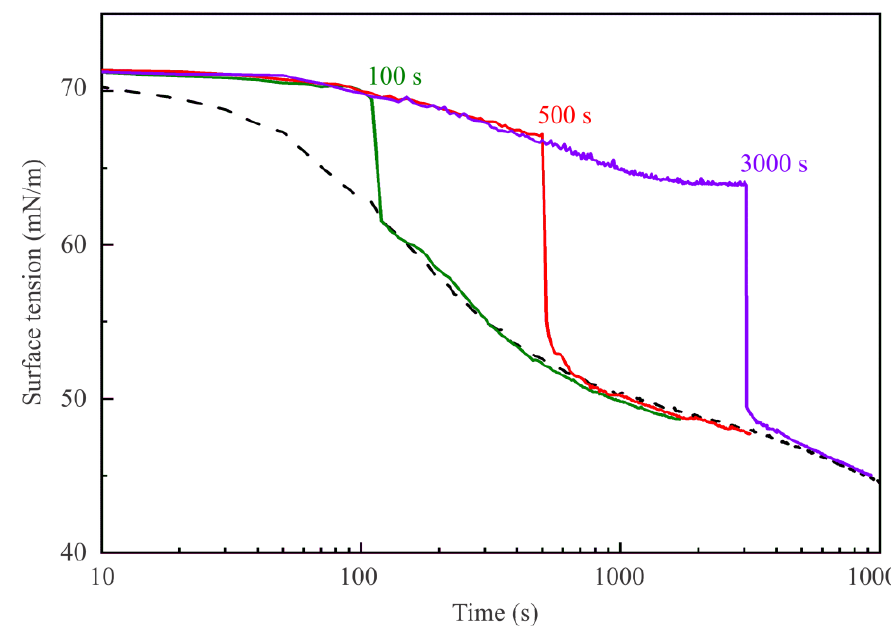
Figure 4. Dynamic surface tension of a 5 µ mol / L C 13 DMPO solution for injections of 2 mL of hexane after 100, 500, and 3000 s of the drop formation moment. Curves for hexane injection at 3000 s and for the hexane injection prior to the drop formation are reproduced from Figure 2.